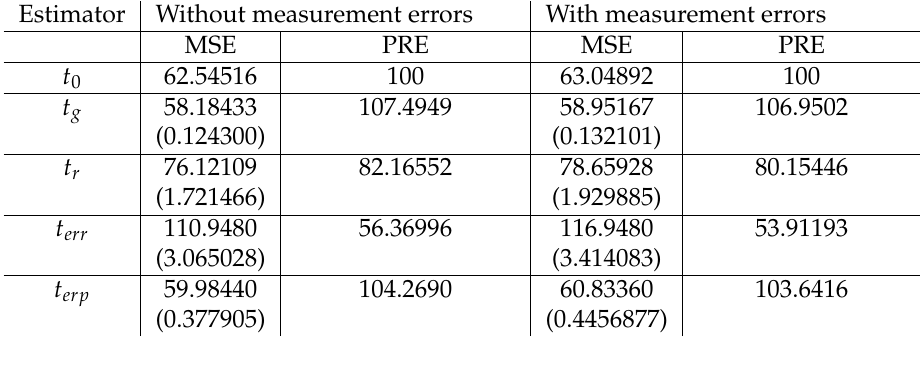
Table 3. Bias (in brackets), MSE and PRE of estimators for population